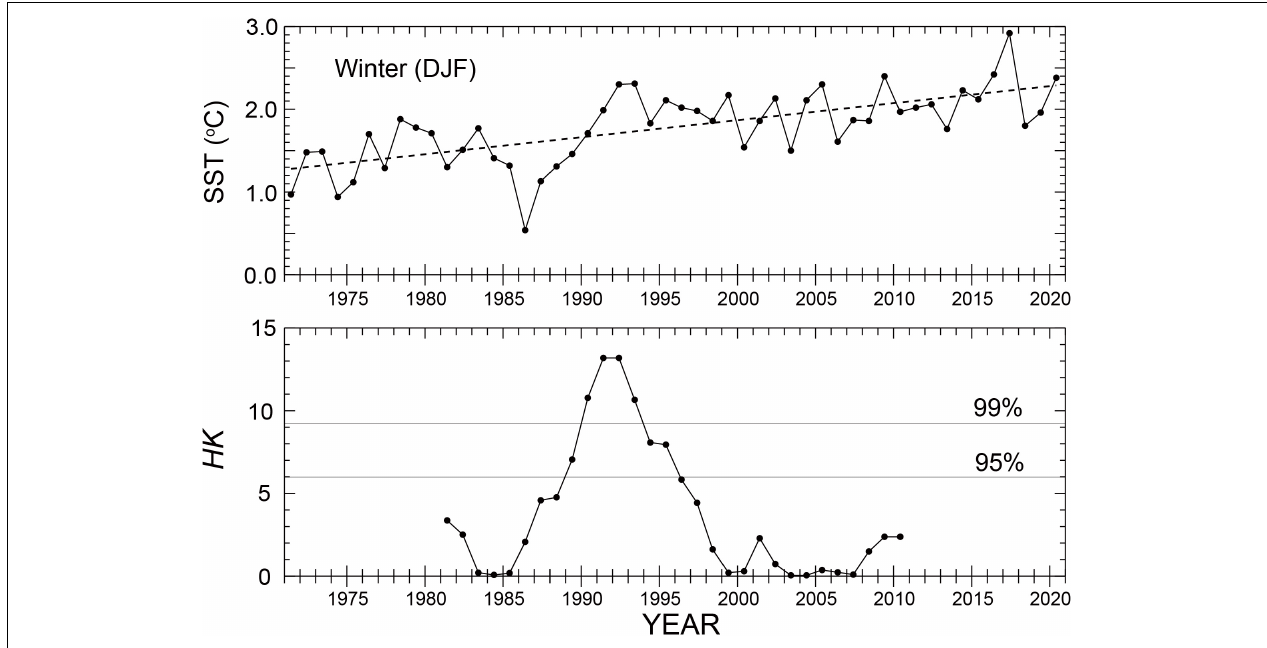
FIGURE 13 | Time series of the areal-mean winter (December–February) sea surface temperature in JW (upper panel). The linear trend for the analysis period is depicted by a dashed line. The lower panel shows the time series of Lepage test statistics ( HK ) with the 99 and 95% confidence levels (thin horizontal